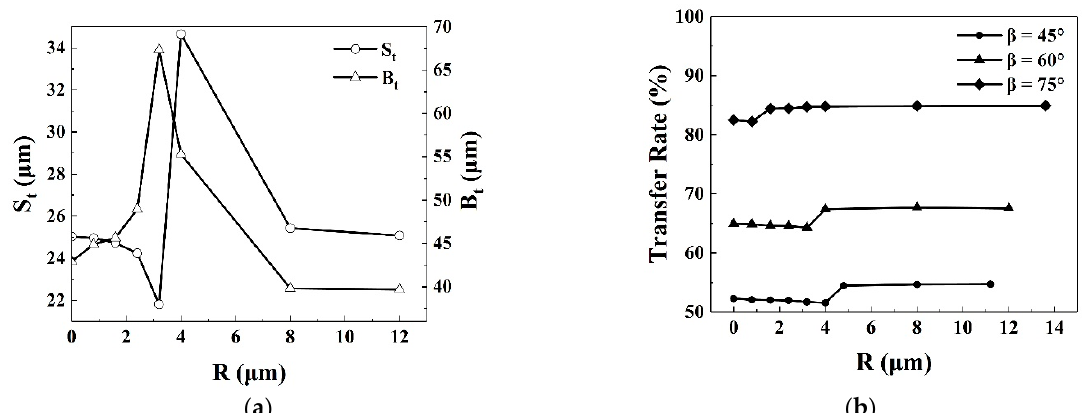
Figure 14. ( a ) The thickness of the thinnest part of the liquid filament and the width of the contact line on the bottom of the cell ( α = 30°, β = 60°, h = 12 μ m); ( b ) the transfer rate with the fillet radius under different β .